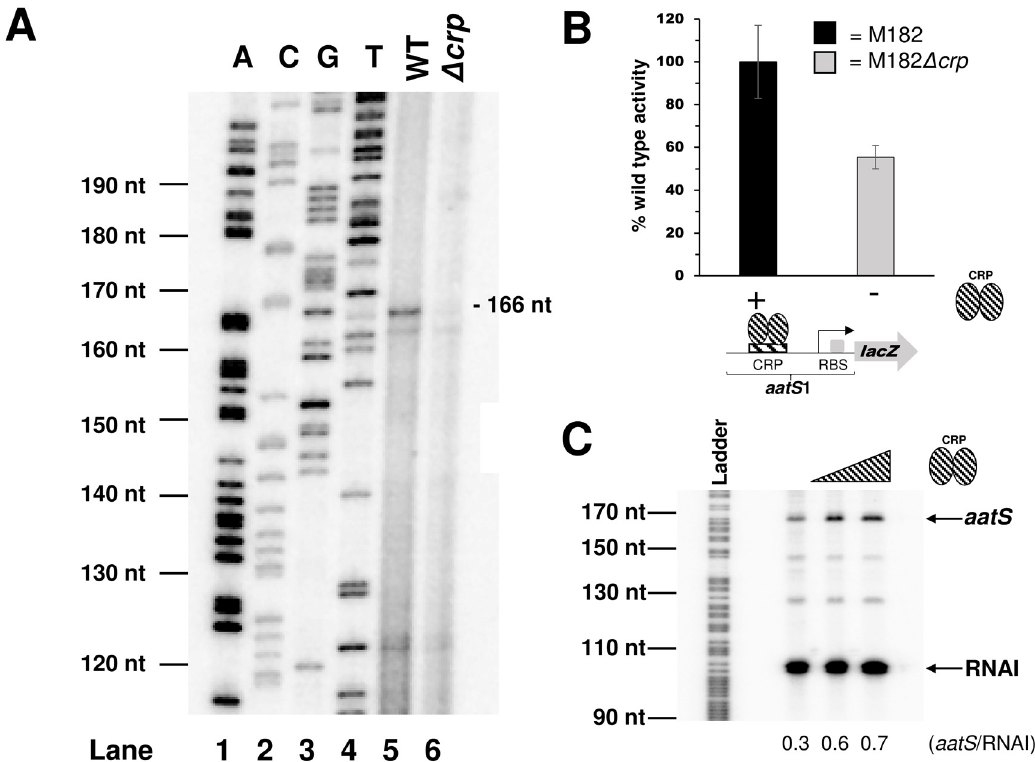
Fig 2. Characterisation of the P aatS promoter. A. Primer extension analysis of the aatS transcript. Lanes 1 – 4 on the gel are arbitrary size standards, used for calibration, generated by sequencing of M13mp18 phage DNA. Lane 5 shows the primer extension product generated using RNA from wildtype M182 cells carrying the aatS 1:: lacZ fusion. Lane 6 shows the primer extension product generated using RNA from M182 Δ crp cells carrying the aatS 1:: lacZ fusion. The transcription start site is indicated in Fig 1B. B. β -galactosidase activity determined using lysates of M182 wildtype or M182 Δ crp cells carrying P aatS cloned upstream of lacZ in plasmid pRW50. Values shown are percentages of activity observed in strain M182 (92 Miller units). We obtained 7 and 3 Miller units of activity from lysates of M182 or M182 Δ crp carrying promoterless pRW50. Error bars represent the standard deviation of three independent experiments. C. Multi- round i n vitro transcription assay using P aatS . The aatS 1 DNA fragment was cloned into pSR upstream of a λ oop terminator. Purified, supercoiled pSR plasmid was incubated with purified CRP at 37°C, and the reaction started by the addition of 400 nM σ 70 - RNA polymerase holoenzyme. CRP concentrations are; 0 nM, 200 nM, or 400 nM. The 108 nt RNAI transcript from the pSR replication origin, and the 169 nt transcript from P aatS , are indicated. The gel is calibrated with an arbitrary G+A DNA sequencing reaction as a size